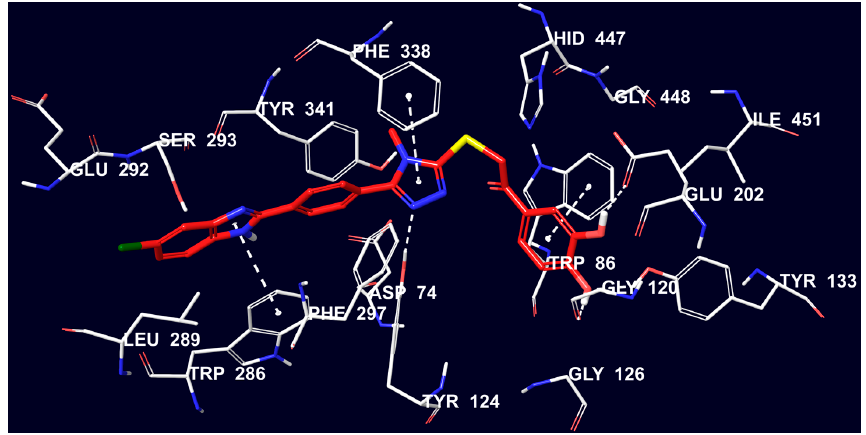
Figure 5. The interacting mode of compound 3d in the active region of AChE. The inhibitor, colored with red, and the important residues, colored with white, in the active site of the enzyme are presented by tube model.